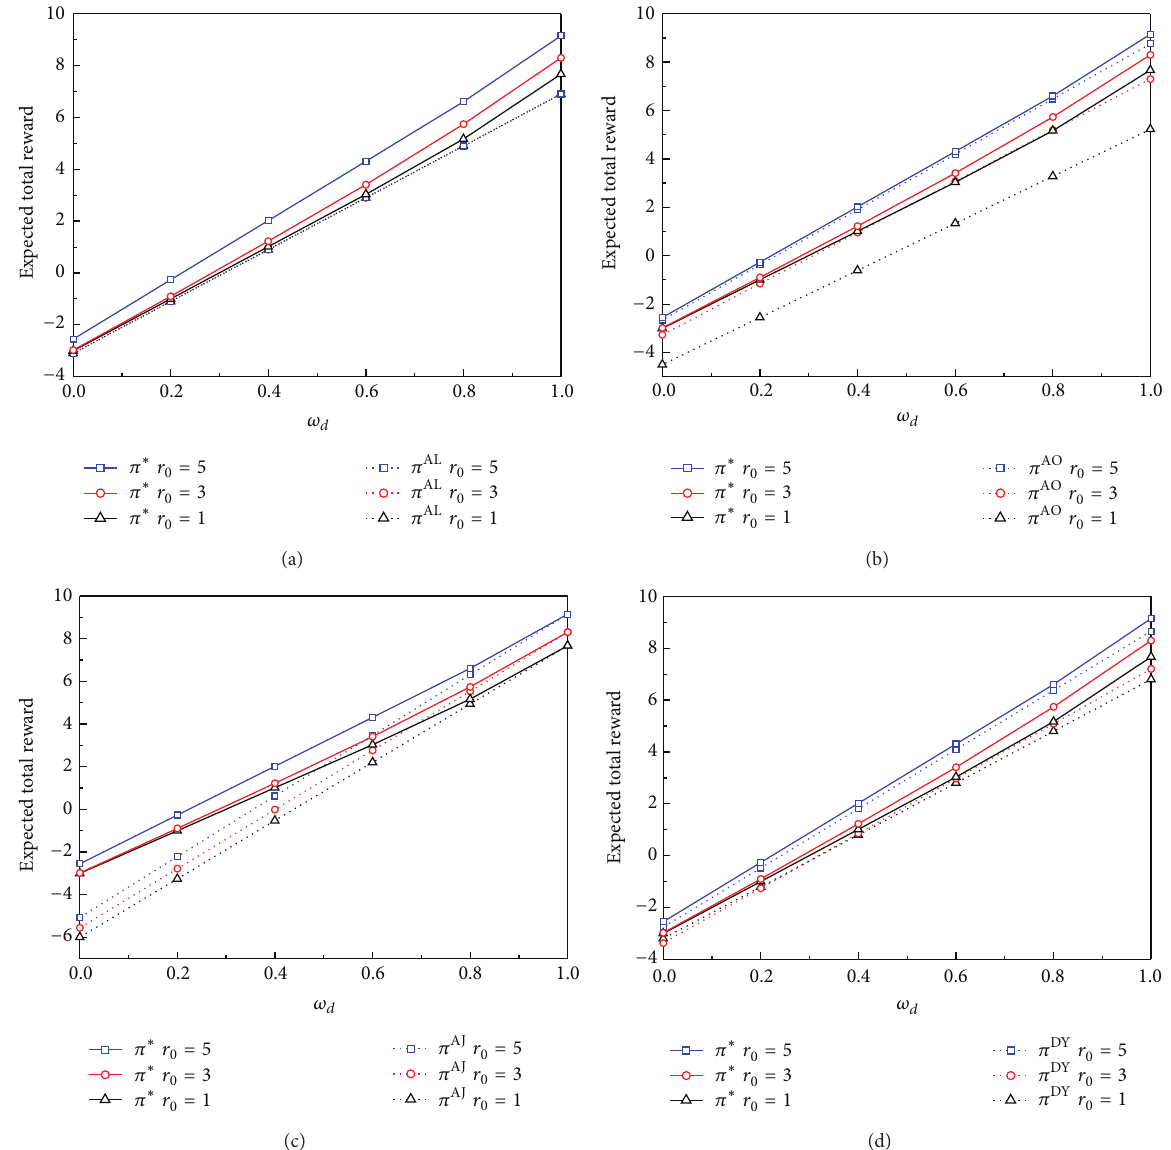
Figure 4: Expected total reward with different initial states and different